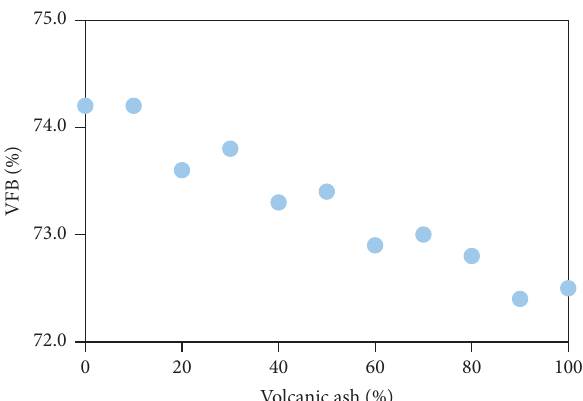
Figure 9: Impact of VA content on tensile strength of HMA.